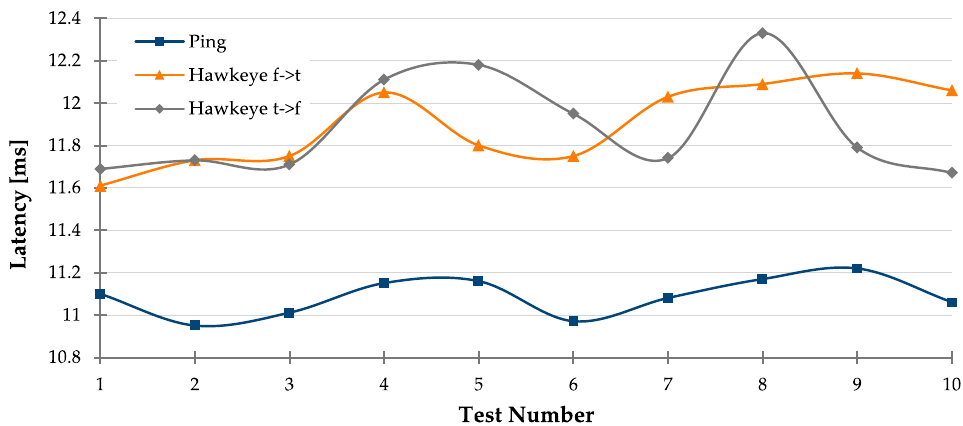
Figure 5. Latency measurements with ping and Hawkeye tests for D2D communication in 5G-NSA.